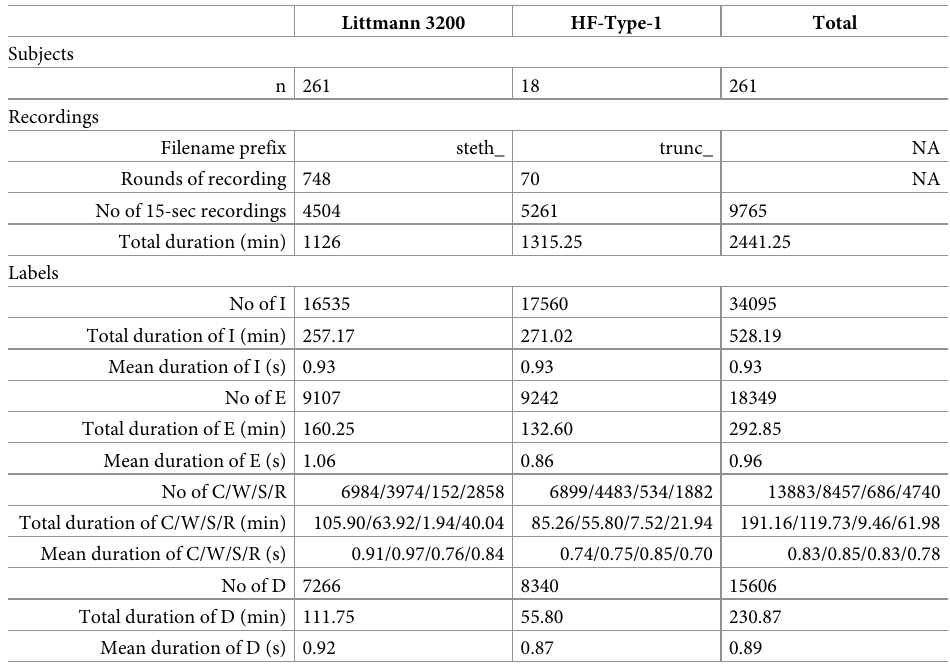
Table 2. Statistics of recordings and labels of HF_Lung_V1